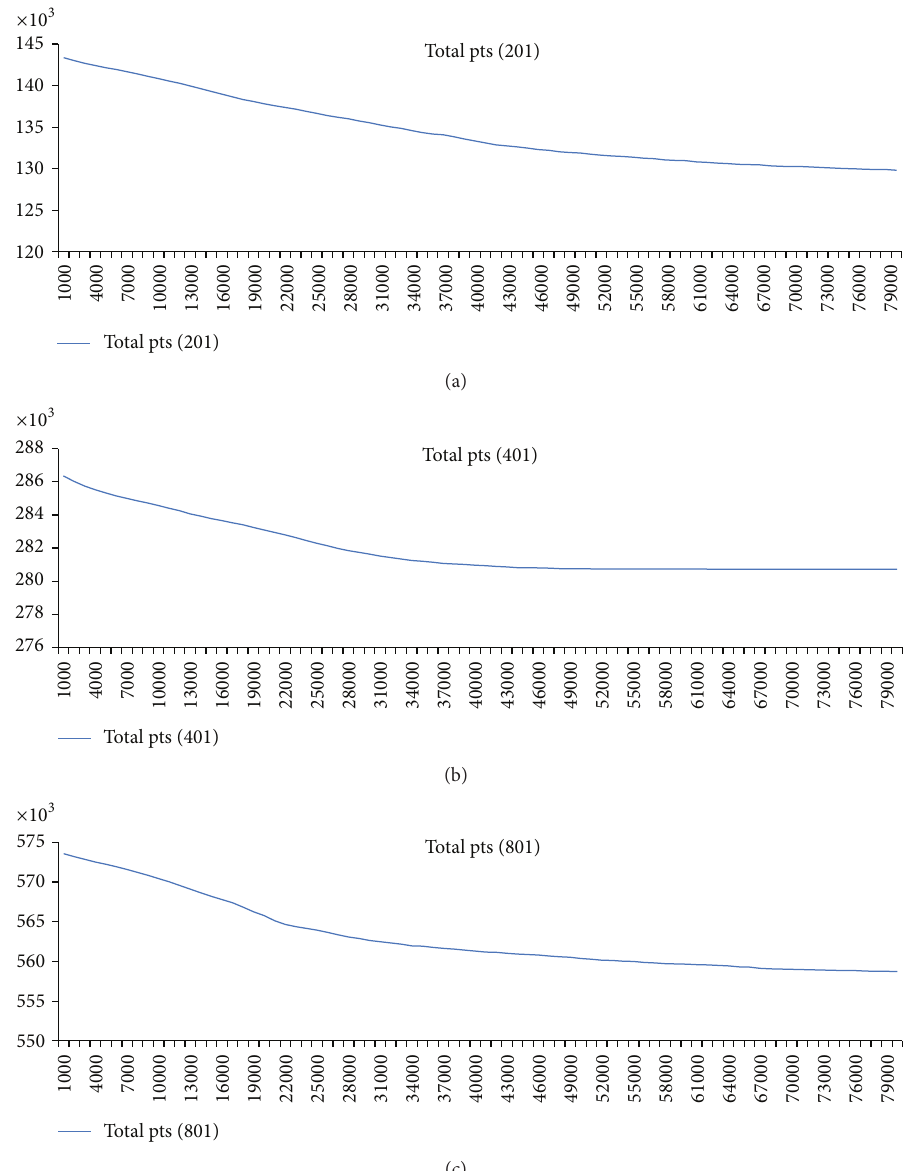
Figure 12: Total points calculated for every 1,000 iterations for the case of 201, 401, 801 column